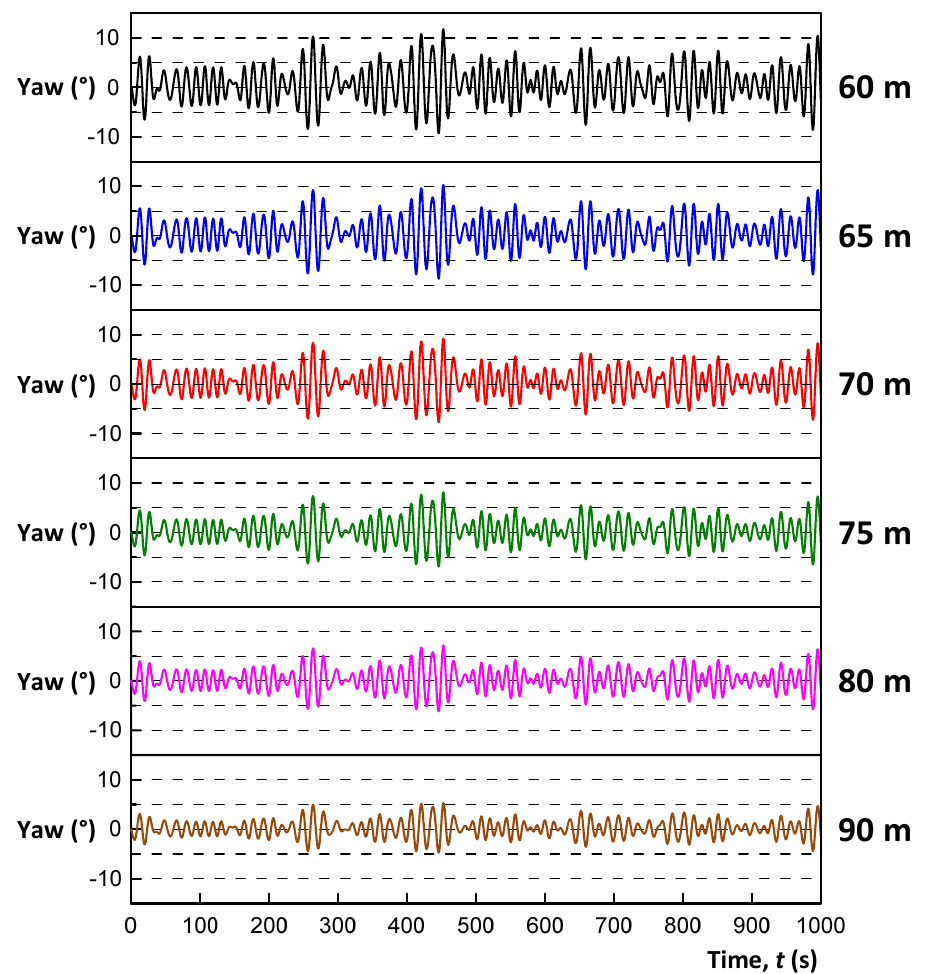
Figure 23. Variation of yaw at different water depths against 90 ◦ storm waves. A dimensionless displacement of the duct motion ( ζ ) was defined as the ratio of duct displacement to its length. Figure 24 depicts ζ of the surge, sway and heave against the dimensionless submerged depth ξ , which was also defined as the ratio of the submerged depth to the wave height of the storm waves. The figure also shows the rotation of roll, pitch and yaw motions of the duct versus the dimensionless submerged depth. The efficiency of PTO of the duct may retain high value when the rotations of pitch and yaw motion are less than 10 degrees. The figure clearly describes the stability of the duct under storm wave is quite related to the dimensionless submerged depth, and the high efficiency of PTO may sustain when the dimensionless submerged depth is larger than 7.4. We, however, would like to suggest the duct should be submerged deeper ( ξ > 9), and the energy harvester can stably collect current energy.